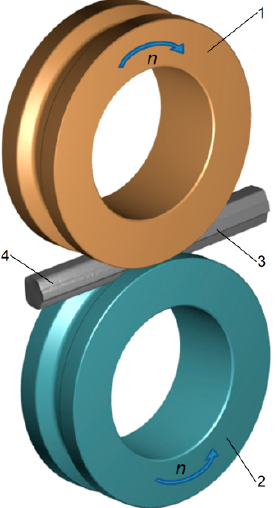
Figure 3. Geometric model of the first stage of the rolling process—longitudinal rolling in the grooved roll pass: 1,2—rolls, 3—rail head, and 4—preform for the second stage of rolling.